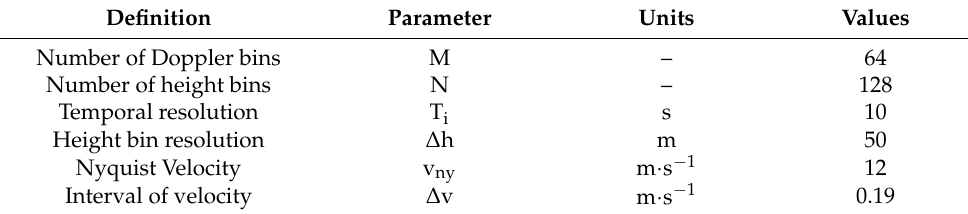
Table 1. MRR- Pro configuration parameters used in this